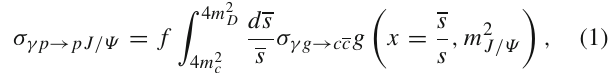
2 Photo-production of J